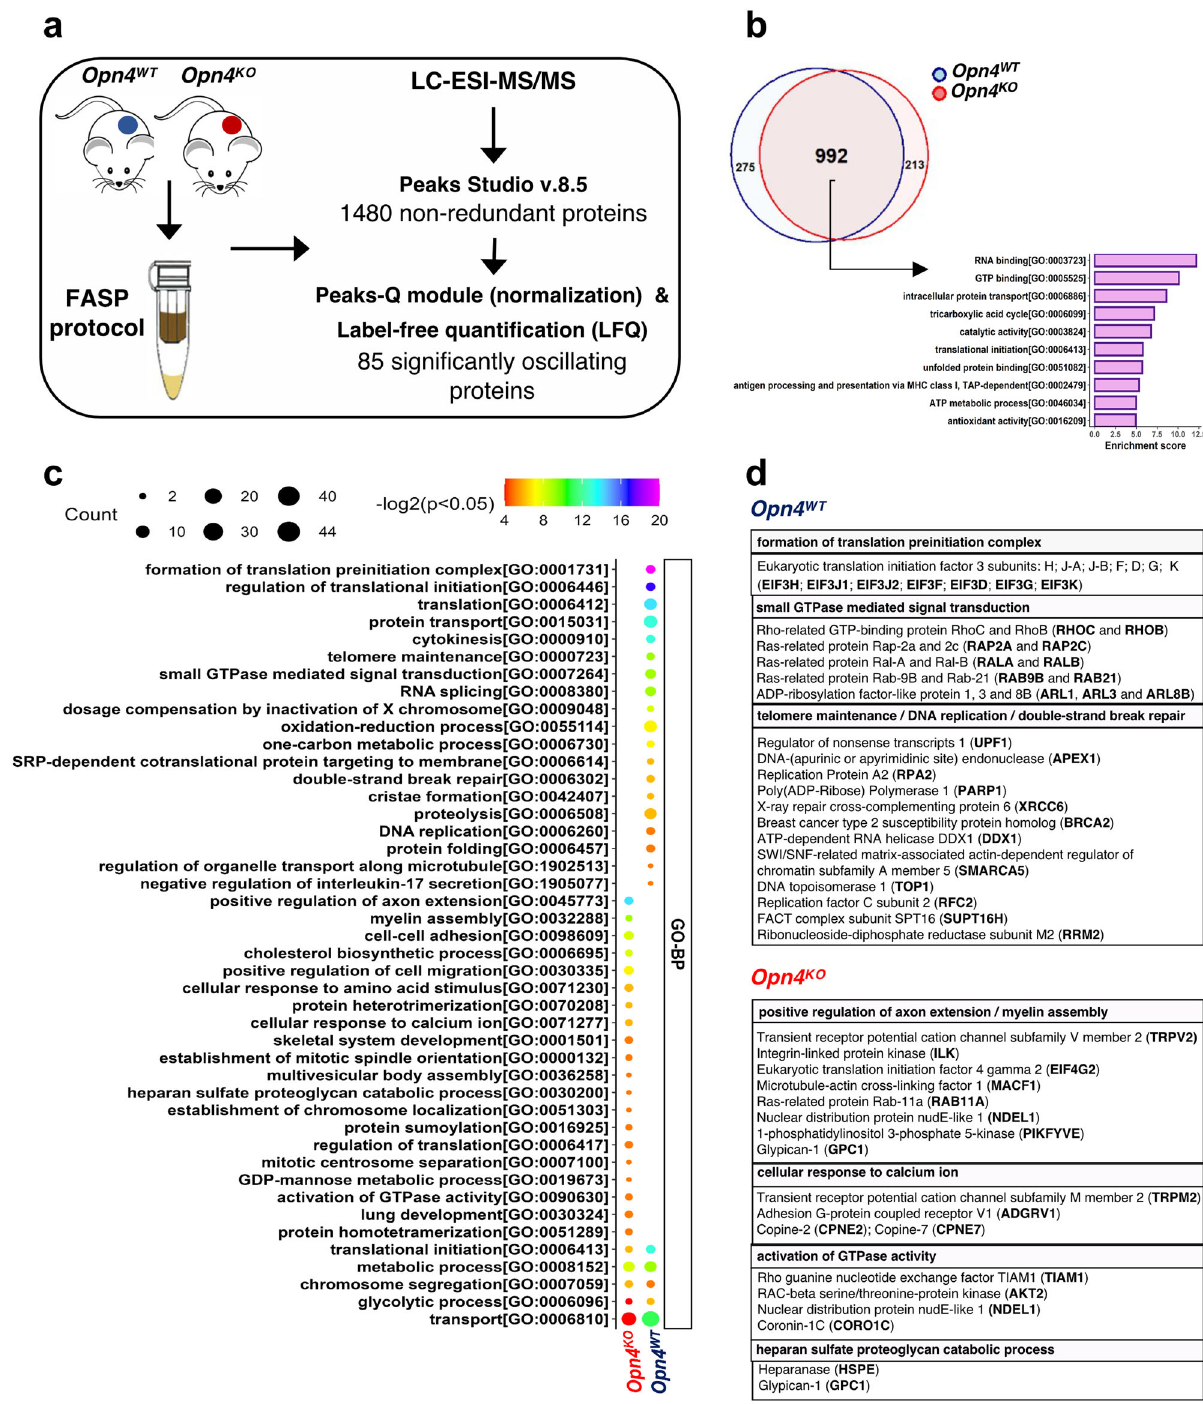
Fig. 6 Overview of proteomic experimental design and selected results. a Experimental protocol. b Venn diagram representing the overlap of results revealed by proteomes of Opn4 WT and Opn4 KO tumors and top 10 functional annotation clustering enriched (Classi fi cation Stringency: low) of commonly identi fi ed proteins in the tumor tissues performed in DAVID ( p < 0.05). c Enrichment analyses of differentially identi fi ed proteins in the tumor proteomes using Gene Ontology (biological process, GO-BP) s performed in DAVID ( p < 0.05). GO-BP terms were fi ltered for redundancy using REViGO. d Detailed view of proteins related to some enriched terms (GO-BP) showing distinct molecular features between Opn4 WT and Opn4 KO tumor are shown. n = 4 for each group comprised of independent